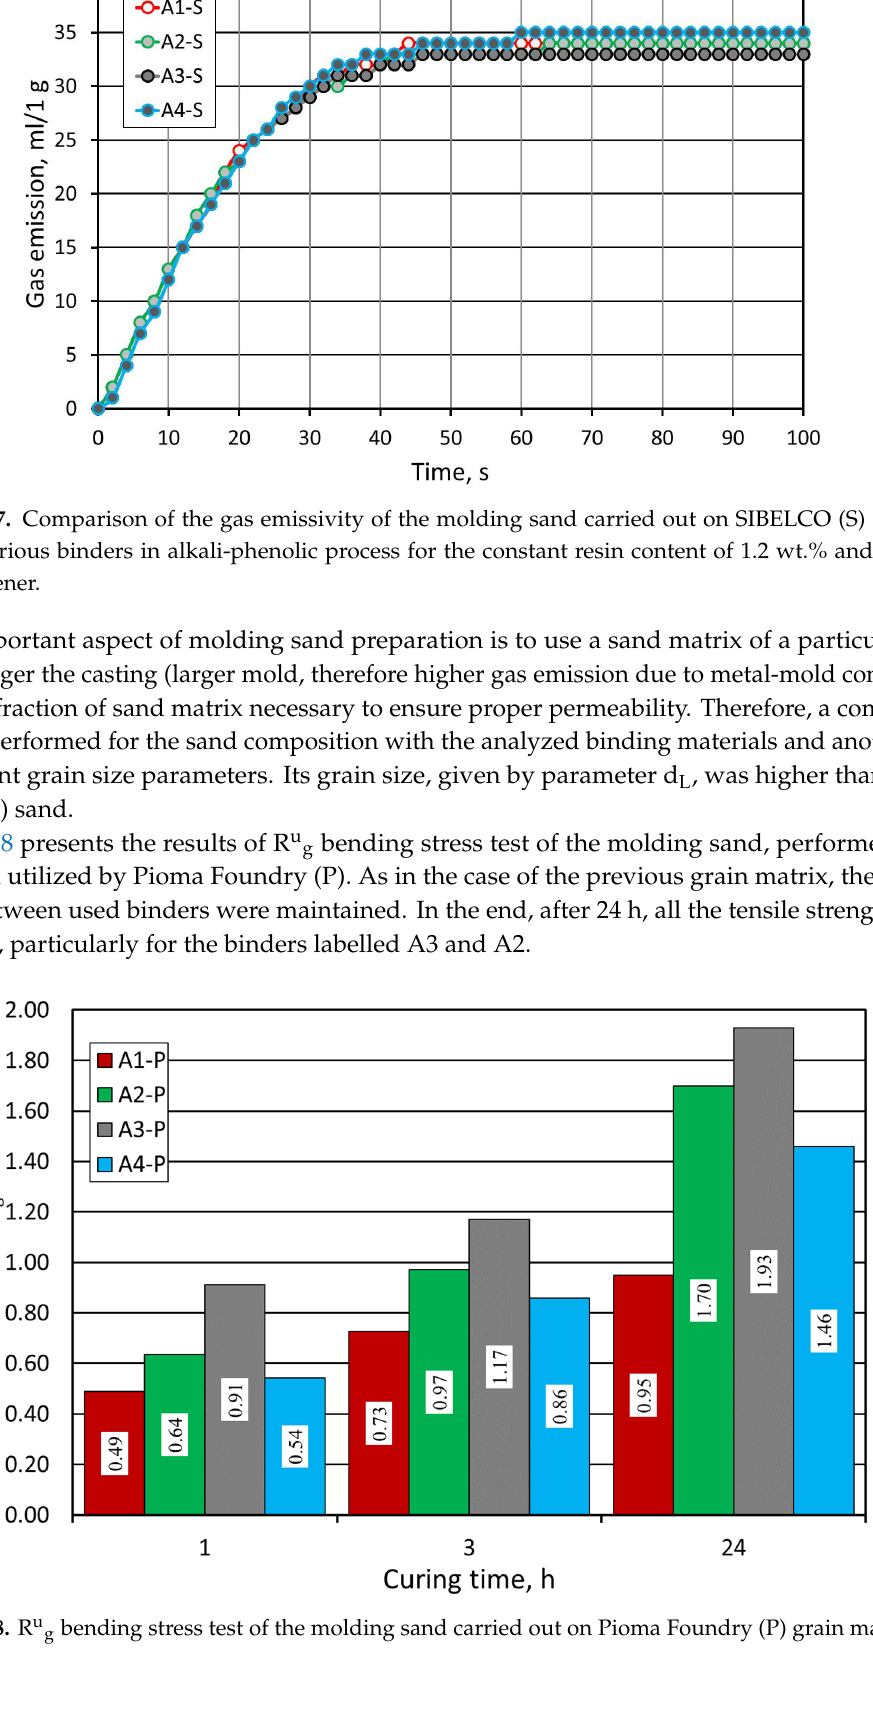
Figure 8. R ug bending stress test of the molding sand carried out on Pioma Foundry (P) grain matrix.